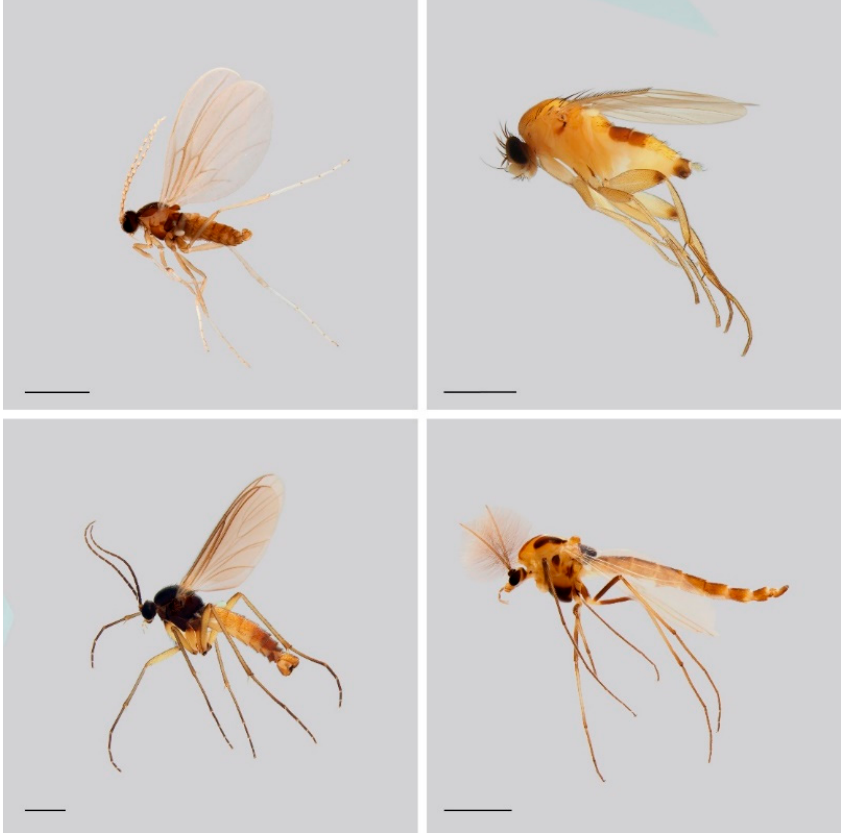
Figure 1. Selected representatives of the DT families analyzed in our study: Cecidomyiidae ( top left ); Phoridae ( top right ); Sciaridae ( bottom left ) and Chironomidae ( bottom right ). Scale bars represent 1 mm.